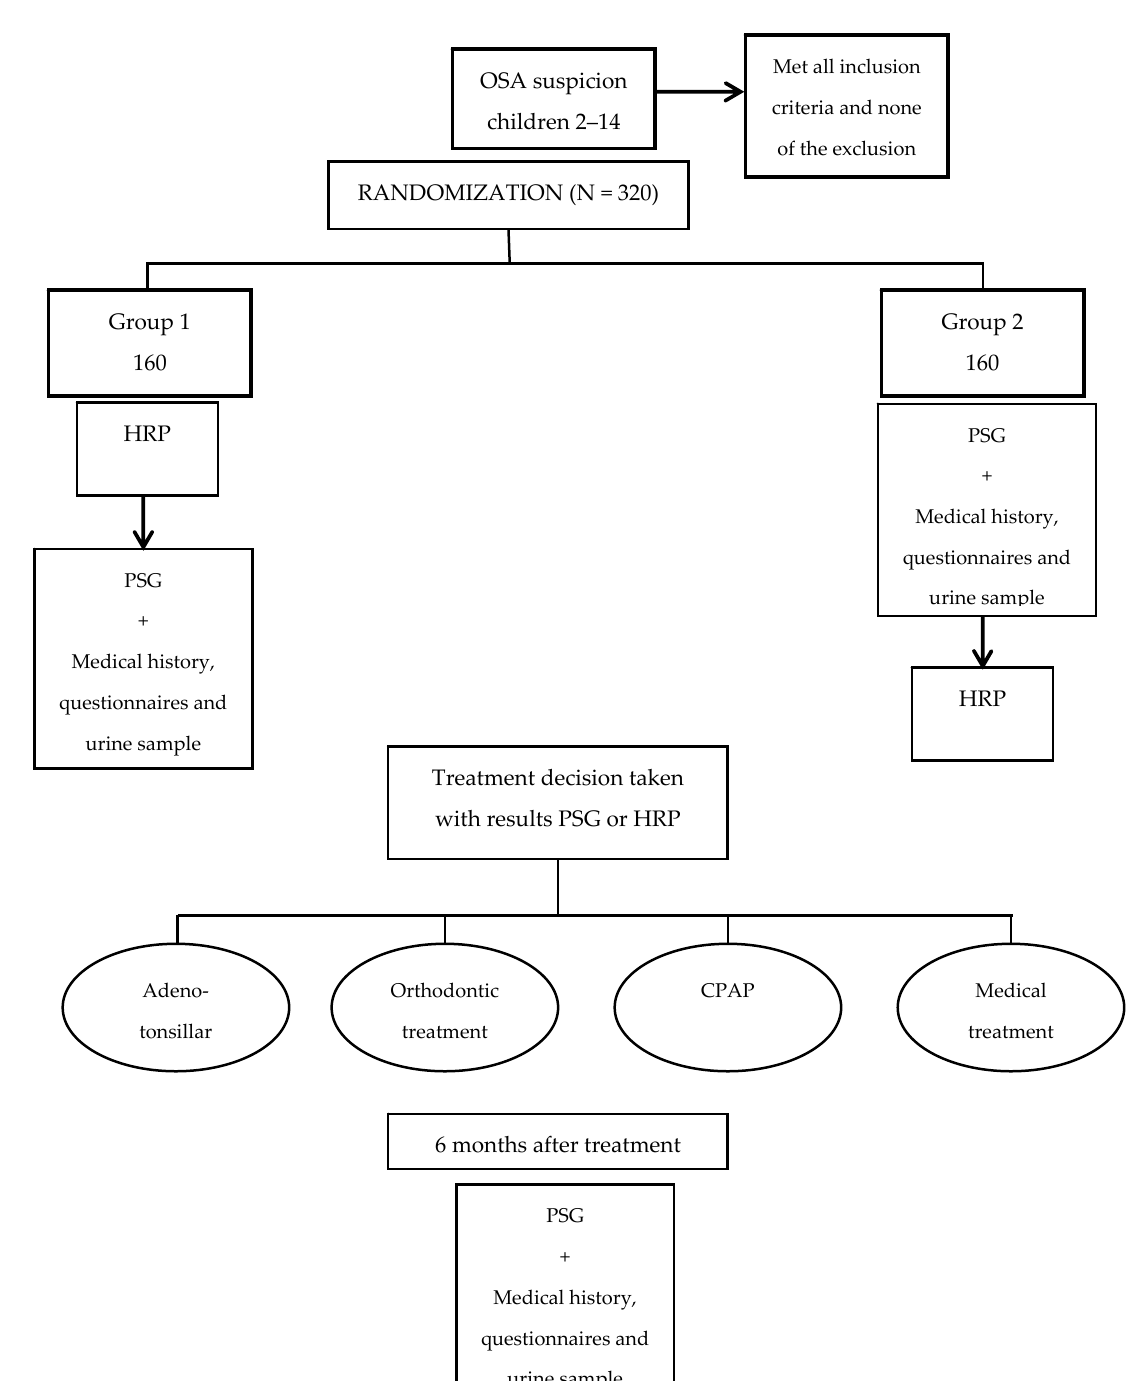
Figure 1. Flow chart and follow up of randomization of children.